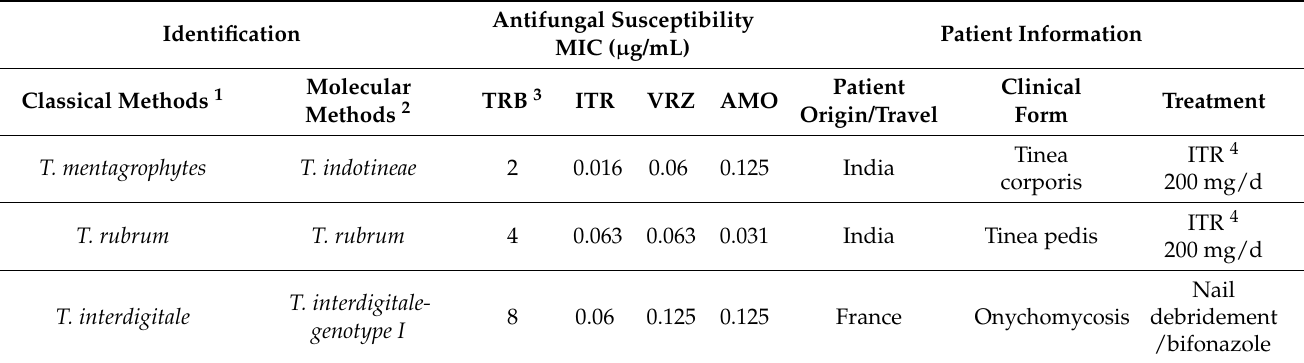
Table 2. Antifungal susceptibility and molecular characteristics of three TerR Trichophyton isolates and patient